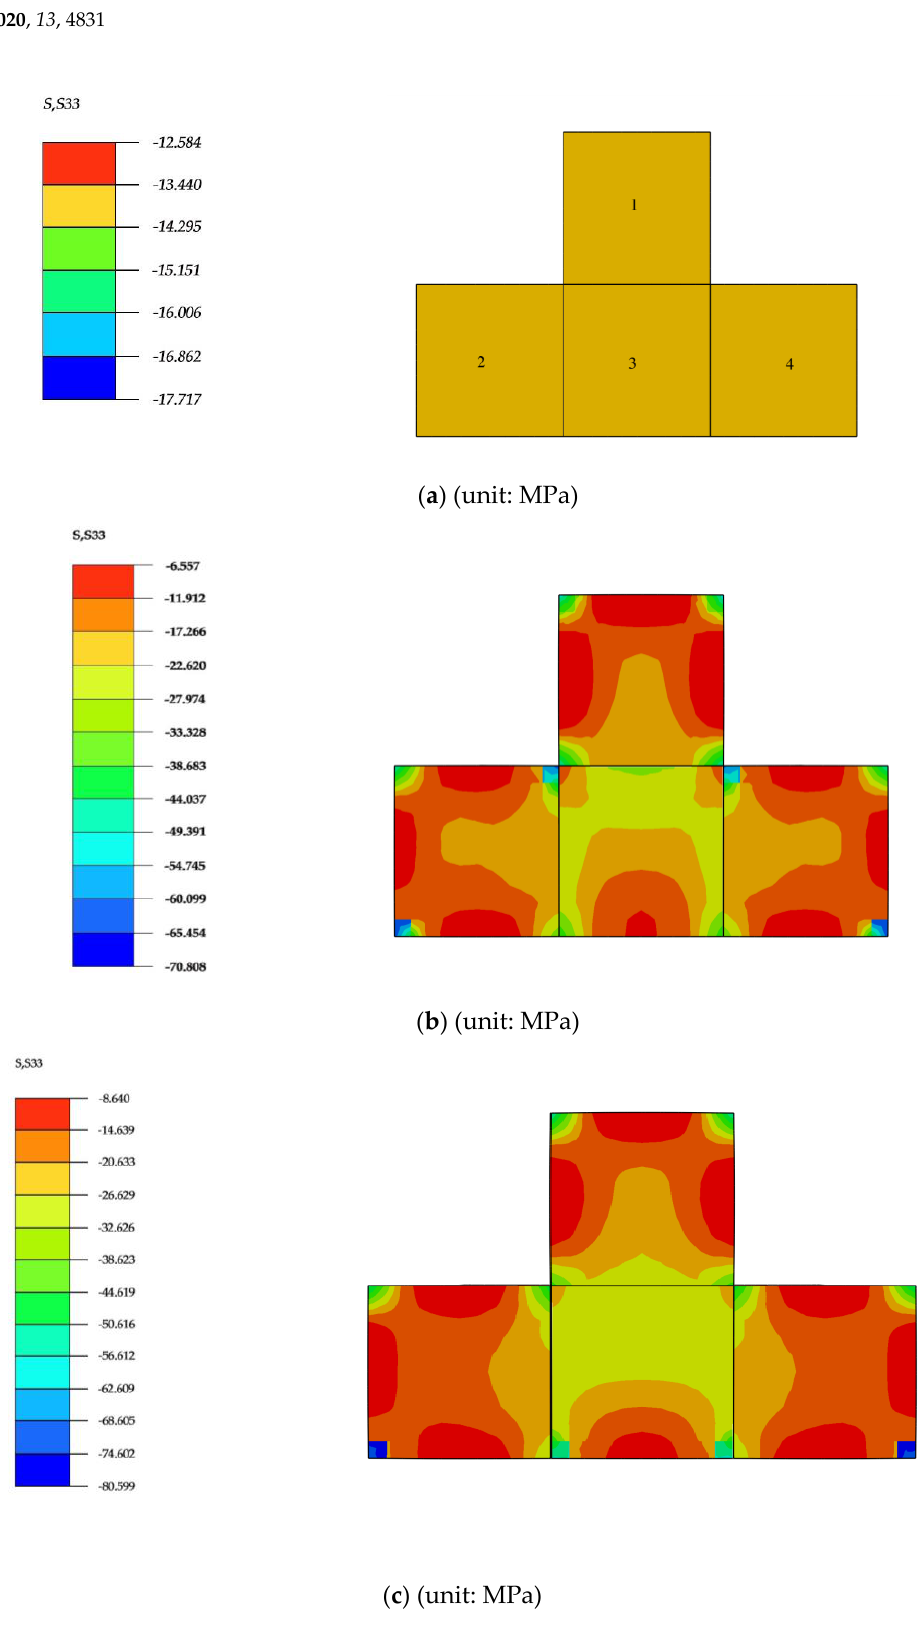
back view in the longitudinal direction.